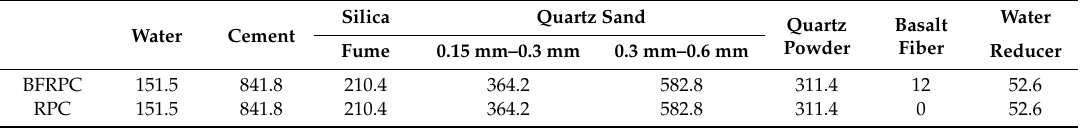
Table 2. Mix proportions of RPC and BFRPC (kg / m 3 ).